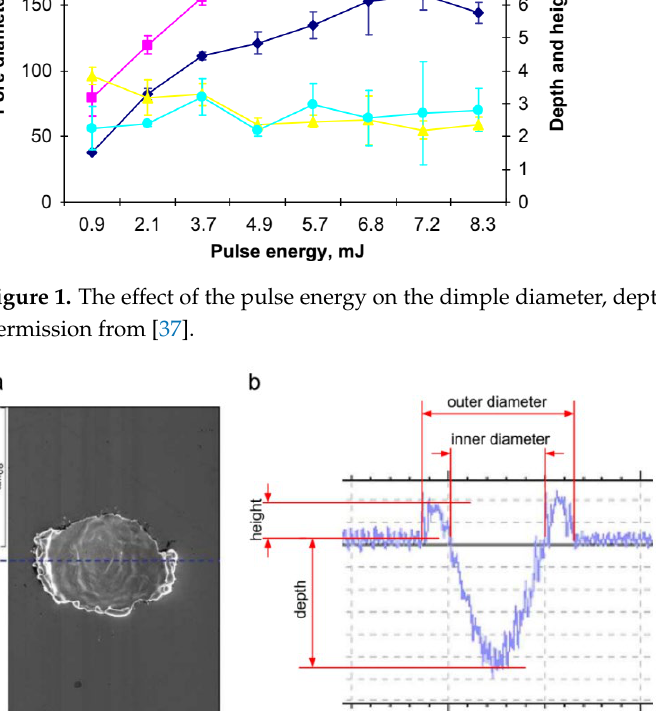
Figure 1. The effect of the pulse energy on the dimple diameter, depth and height. Reproduced with permission from [37].